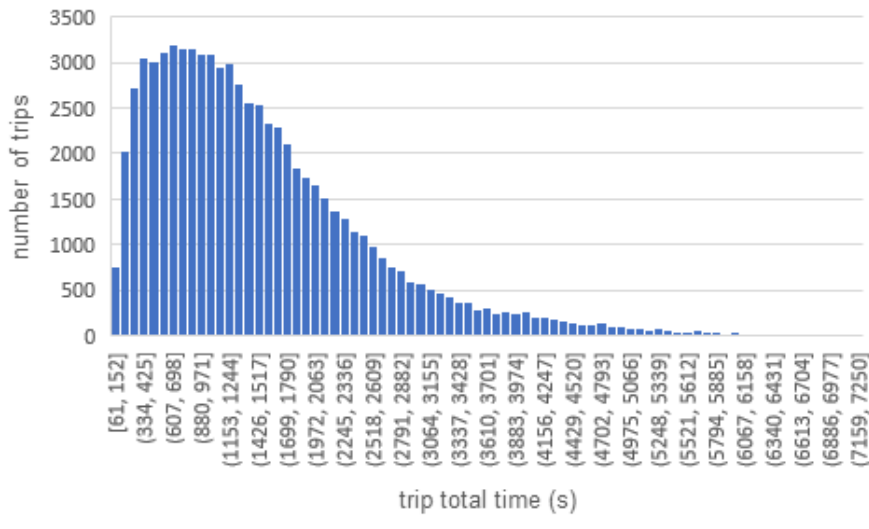
Figure 6. Histogram of trip time. Image source: the authors.